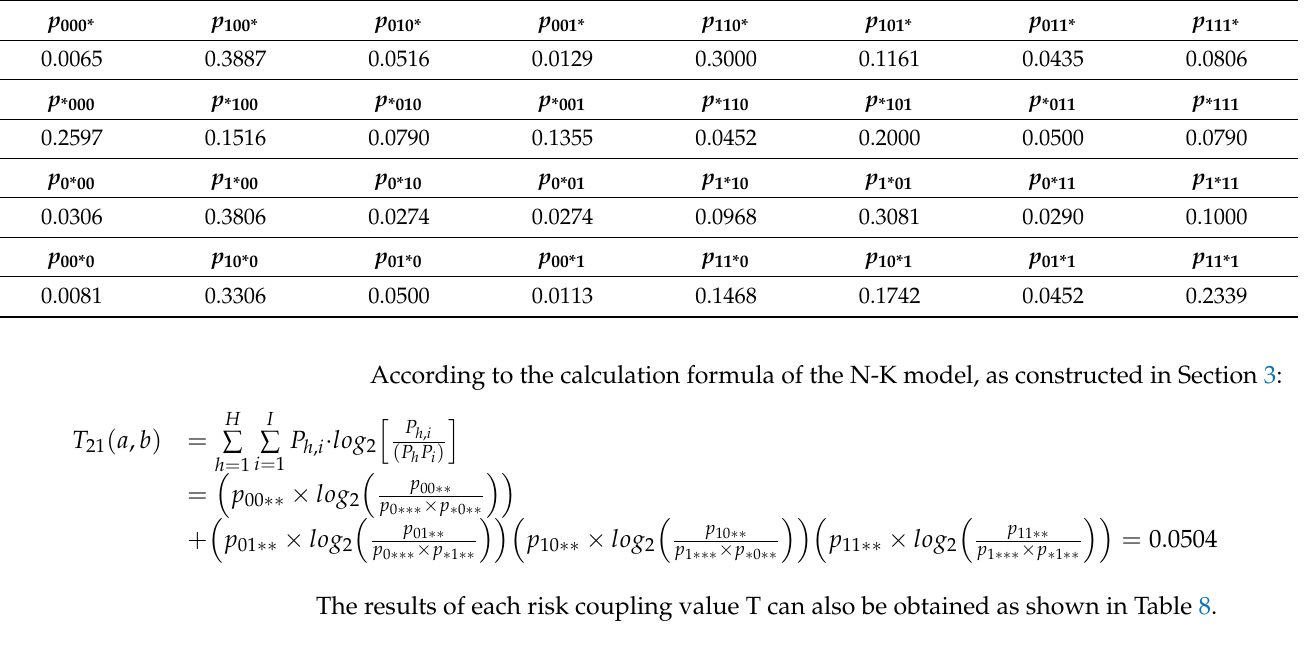
Table 7. Multi-factor changes probability of marine